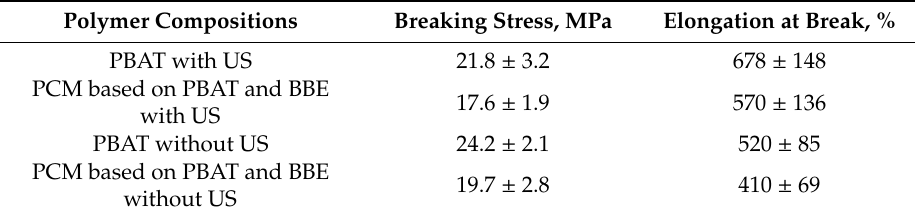
Table 4. Physico–mechanical properties of polymer compositions.